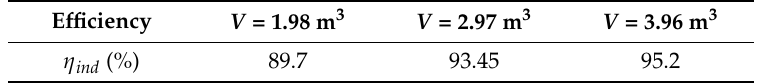
Table 5. Efficiency system for the first configuration varying the Volume of the tank.